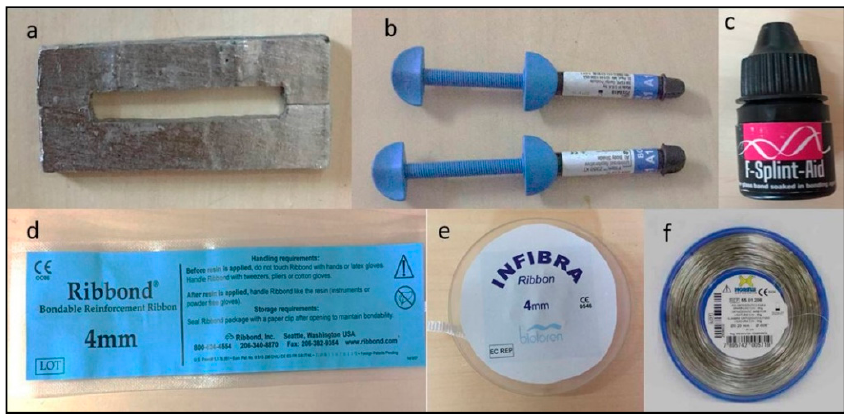
Experimental materials: ( a ) Metallic mold, ( b ) Flowable composite resin syringes, ( c ) F-splint-Aid ® , ( d ) Ribbond ® , ( e ) InFibra ® , ( f ) Morelli ® Ligature wire.